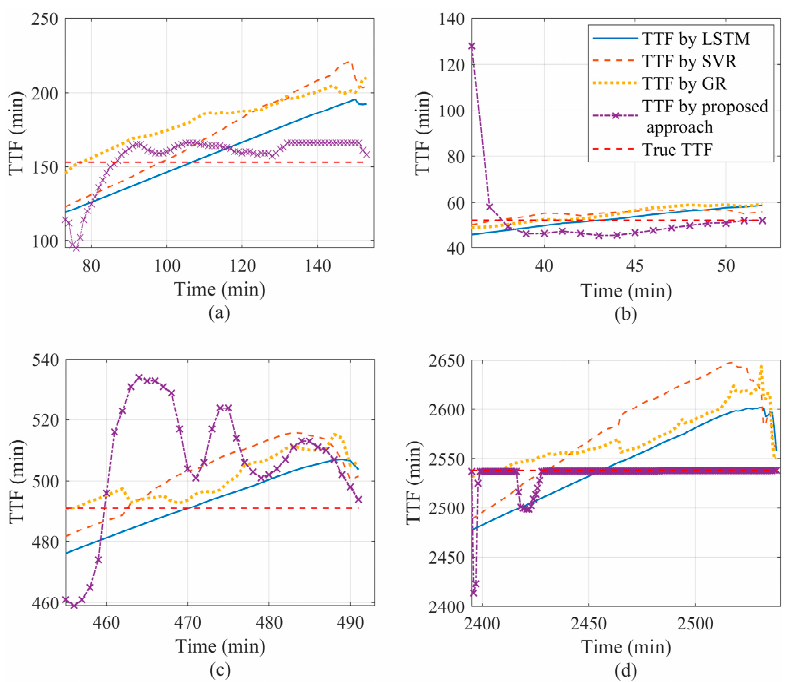
Figure 9. TTF prediction results of different approaches for ( a ) bearing 1_3, ( b ) bearing 1_5, ( c ) bearing